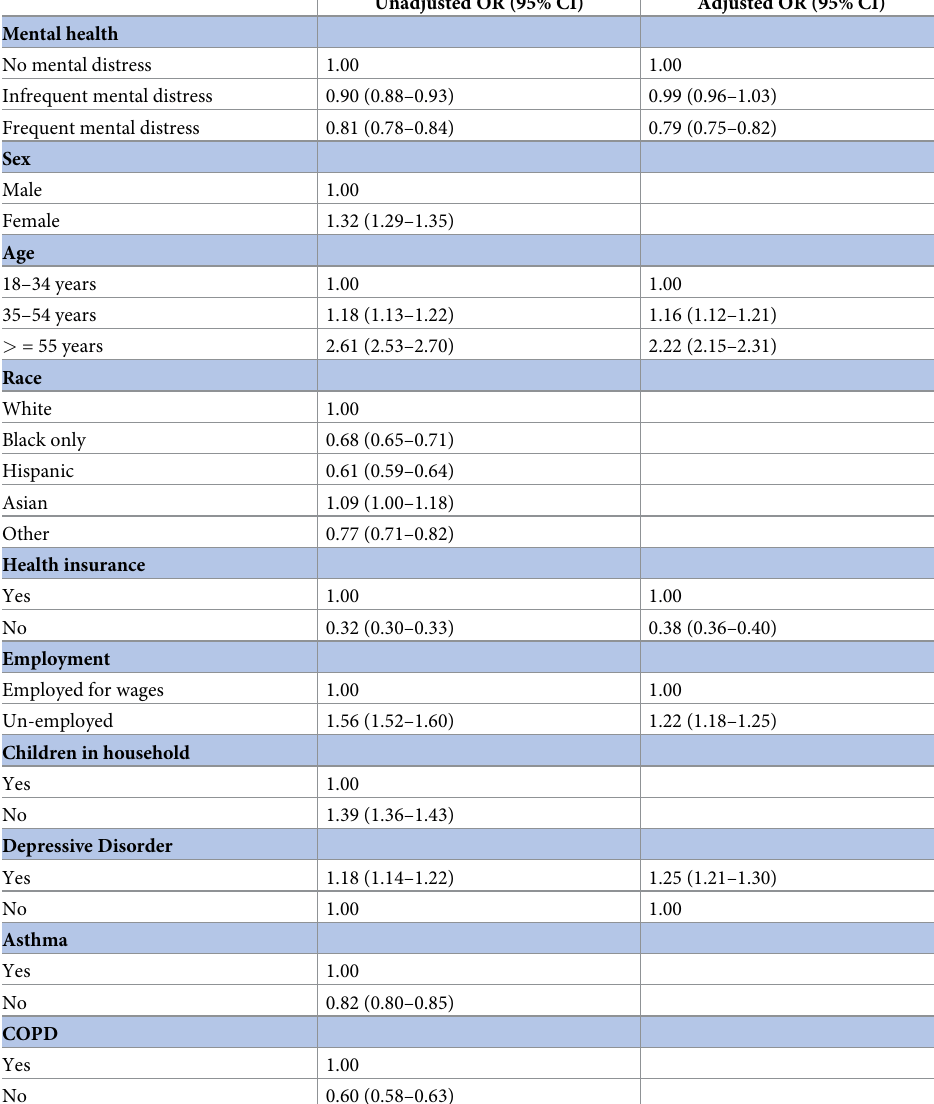
Table 2. Unadjusted and adjusted OR of US adults having received the influenza vaccine among US adults, BRFSS